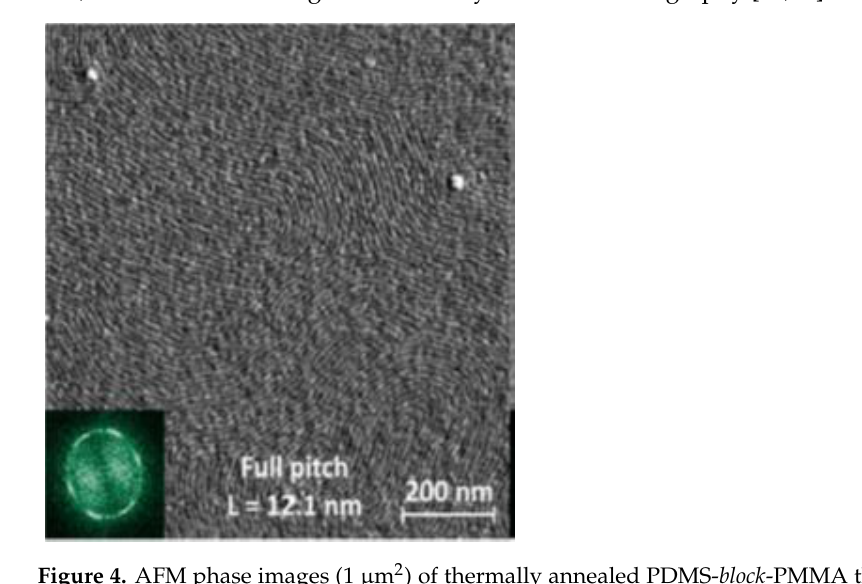
Figure 4. AFM phase images (1 μm 2 ) of thermally annealed PDMS- block -PMMA thin film. Repro- duced with permission [64]. Copyright 2015, American Chemical Society.